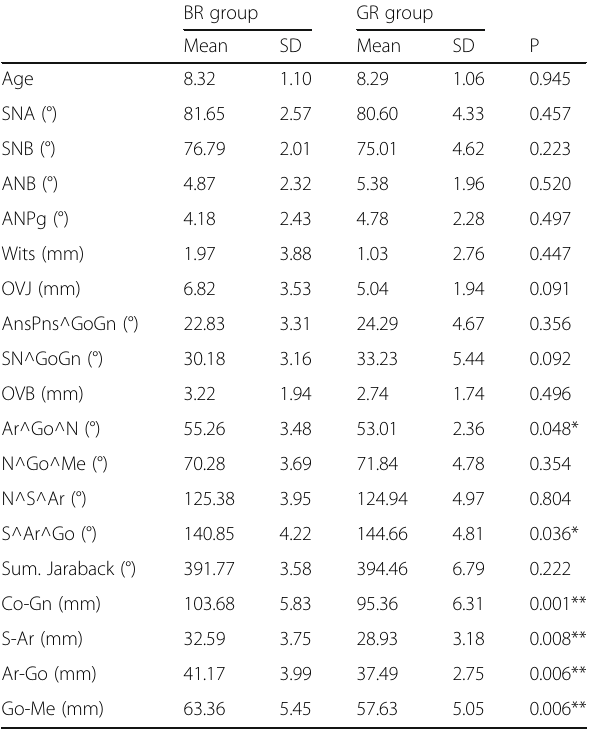
Individual Score ¼ Table 2 Comparison between BR and GR groups